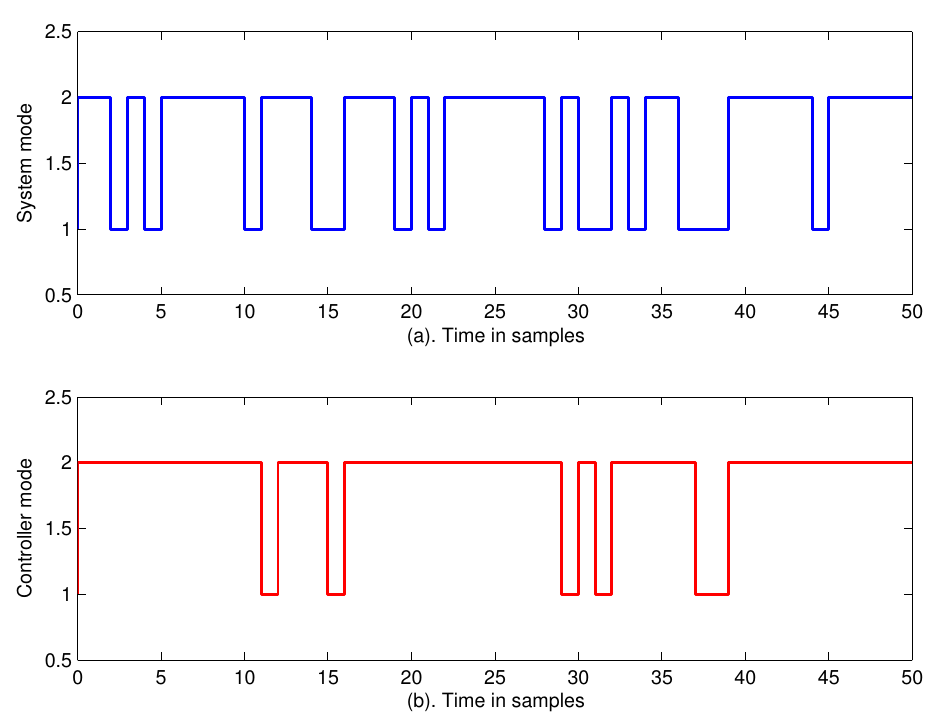
Figure 2. Simulation of system and controller